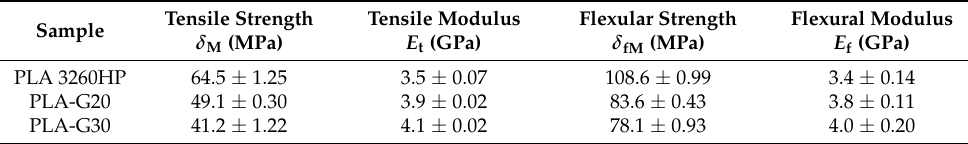
Table 8. Tensile and flexular properties of PLA/grass